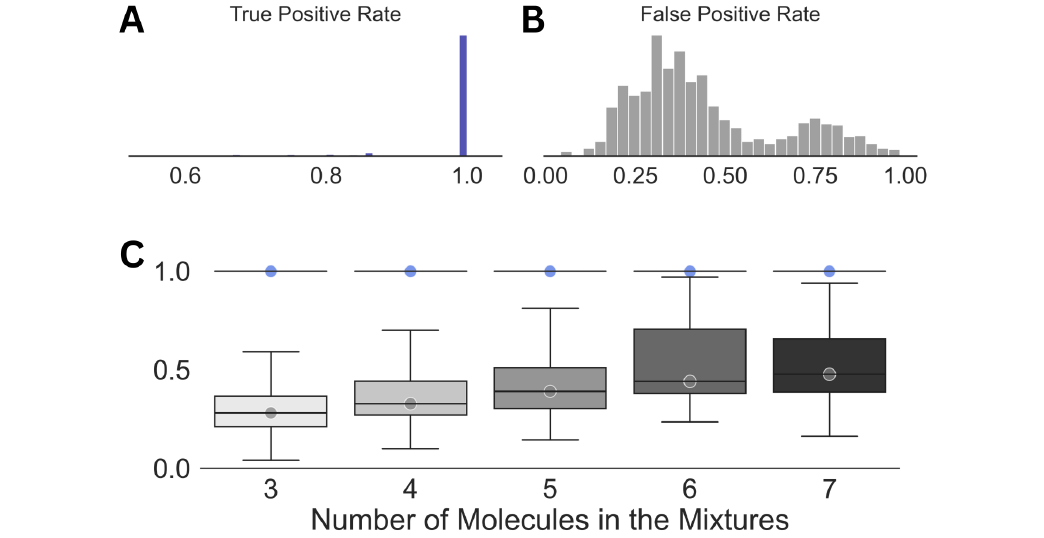
Figure 3. Summary of the results obtained in Step (3) of the analysis. Distributions of the true positive ( A ) and the false positive rates ( B ) for the entire dataset along with those against the size of the mixtures ( C ) are shown. The circles in ( C ) emphasize the median true positive rate (blue) and false positive rate (gray) for each of the distributions. For all the cases, a true positive rate of 1.0 was achieved (standard deviation =